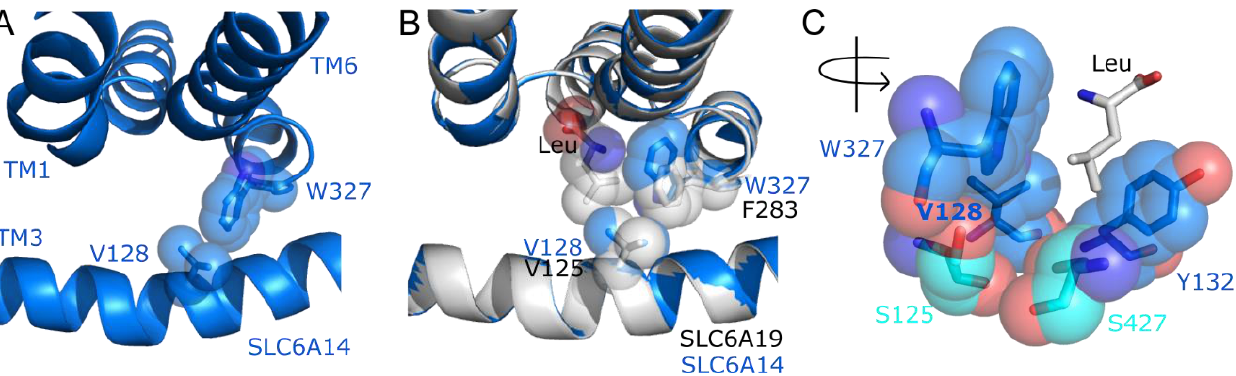
Figure 5. SLC6A14 V128 is in close proximity to a “sensor residue” position in TM6 of NSS trans- porters suggesting V128F could disrupt cation- π interactions between TM6 and cationic substrates or reduce flexibility of the substrate binding pocket. ( A ) Predicted structure of human SLC6A14 taken from the AlphaFold Protein Structure Database. Only sections of TM1, TM3 and TM6 are shown for clarity. V128 in TM3 and W327 in TM6 are shown as spheres and sticks. ( B ) Homology model of SLC6A14 (blue) created using, and overlaid on to, the crystal structure of SLC6A19 (grey, PDB: 6M17). The SLC6A19 substrate leucine and named residues (grey or blue) are shown as spheres and sticks. ( C ) Homology model of SLC6A14 created using the crystal structure of SLC6A19 (6M17). The image is rotated around the vertical axis compared to ( A , B ). Residues predicted to line the deep part of the binding pocket are shown as sticks and spheres with S427 (TM8) and S125 (TM3), which appear to form a polar cleft, highlighted in cyan. Other residues are V128 (TM3), the highly conserved gating residue Y132 (TM3), and W327 (TM6). To aid visualisation of the predicted binding pocket the leucine bound to the 6M17 crystal structure was included as for ( B ).